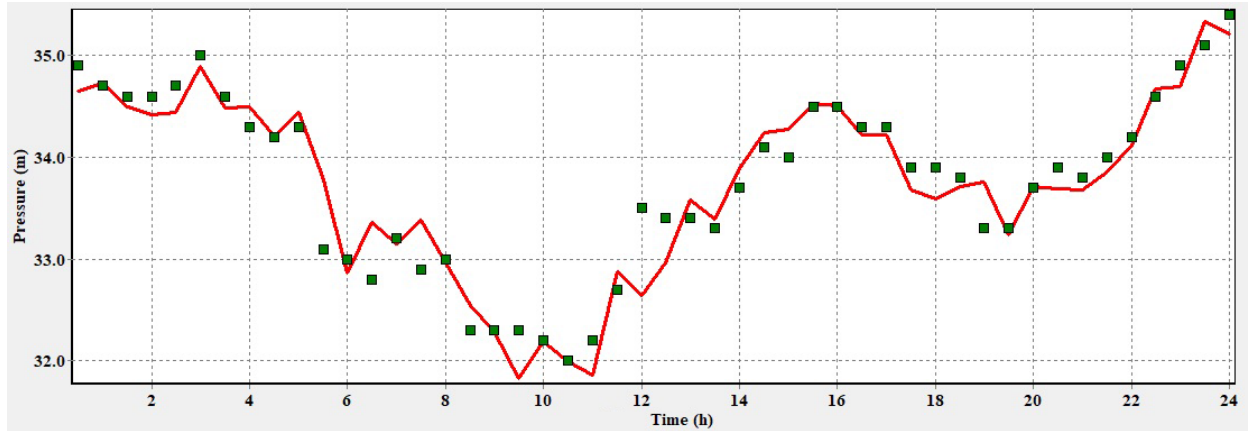
Figure 14. Pressure profile at